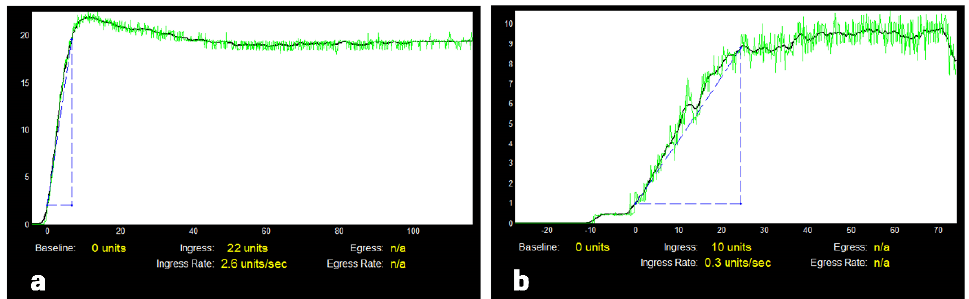
Figure 2. Intraoperative quantitative ureteral microperfusion at the proximal third in ICG fluorescence angiography during kidney transplantation: ( a , b ) show examples of output files after quantification with SPY-Q. The graphs illustrate the increase and decrease of ICG fluorescence intensity over a period of 138 s after systemic administration of ICG: ( a ) typical ureteral perfusion pattern, ( b ) reduced perfusion in a patient with a posttransplant ureterovesical anastomosis complication.